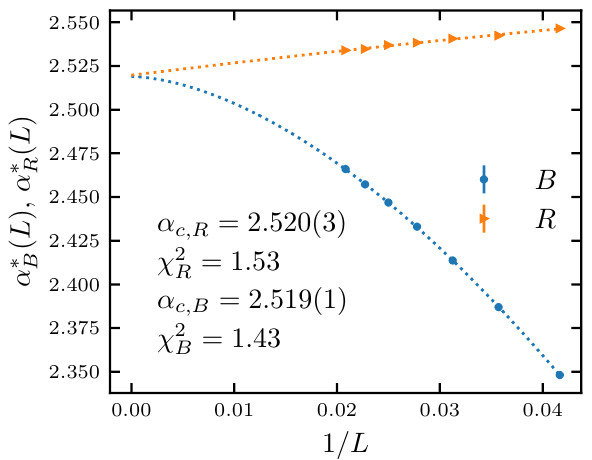
Figure 3: Crossing points for both the Binder cumulant B (circles) and the log string- order parameter ratio R (triangles) as a function of 1 / L for different system sizes. The dashed lines show the extrapolation to the thermodynamic limit and the legend indicates the extrapolated value along with the normalized χ 2 value for the